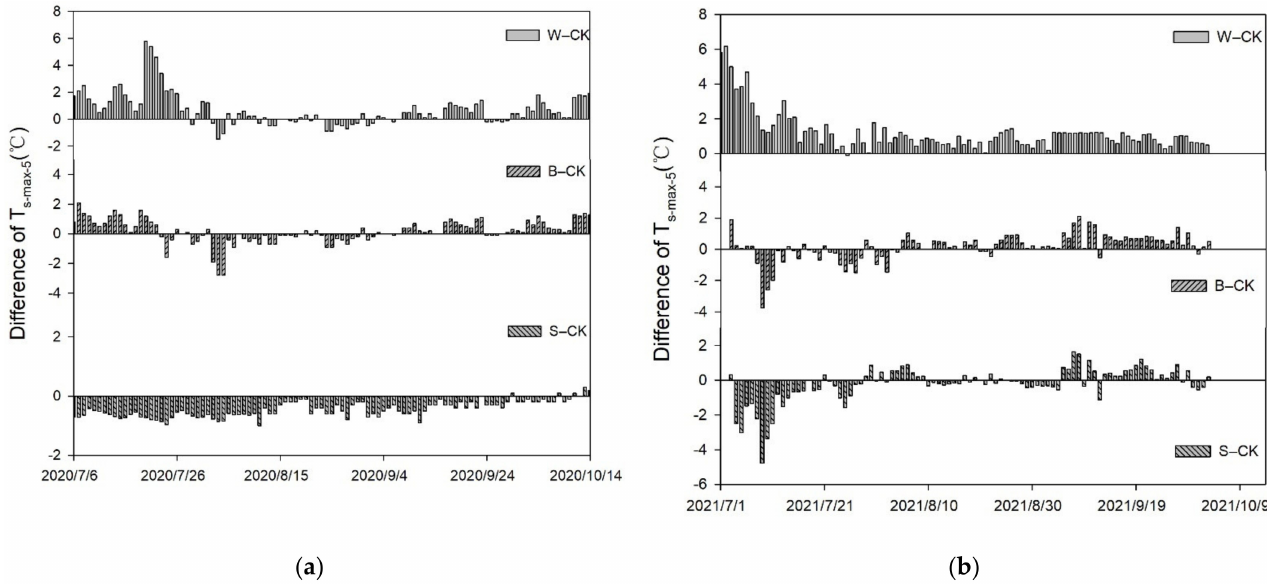
Figure 2. Comparison of daily maximum soil temperature at the depth of 5 cm below ground (T s-max-5 ) in the maize growing seasons in 2020 ( a ) and 2021 ( b ) among all treatments. The bars in the figures show the T s-max-5 differences between the three mulching treatments (W, B, and S are transparent film, black film, and straw mulching, respectively) and the